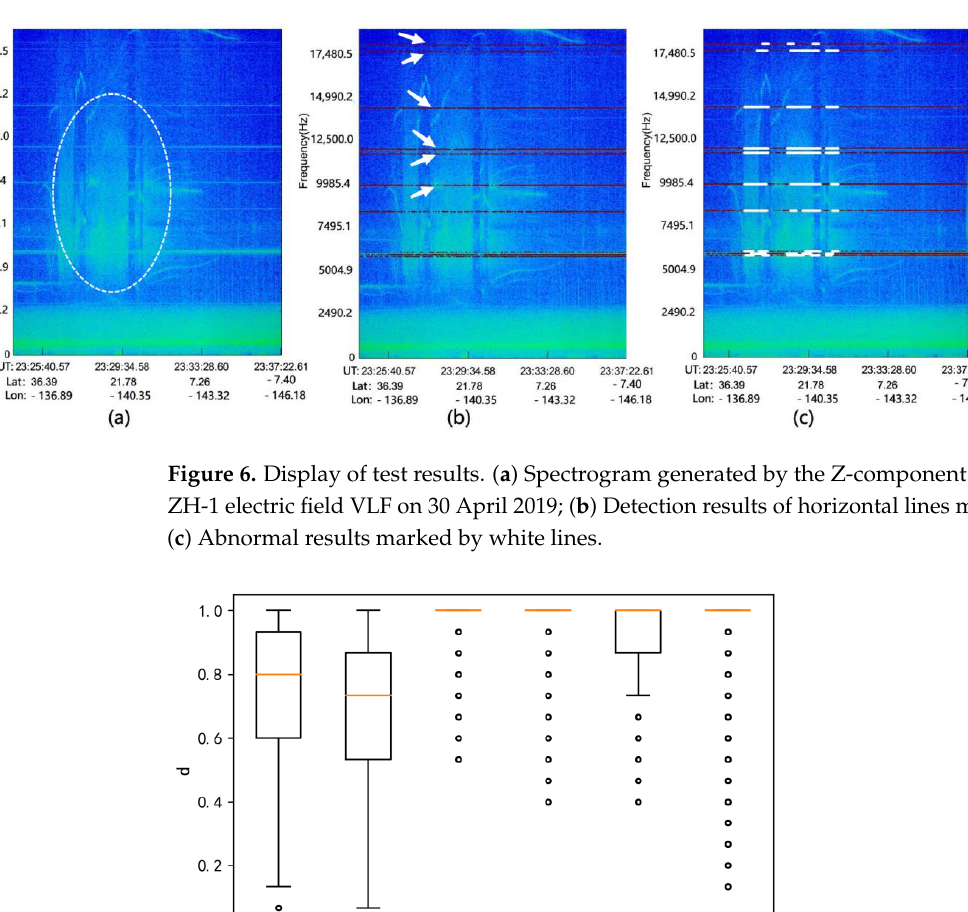
Figure 5. Histograms of the density of all windows on lines. Each subgraph represents a straight line, the title of each subgraph is the line number, and the histogram on each subgraph is the statistical distribution of the density of all the sliding Windows on a straight line. The density values range from 0 to 1, and the width of each column is 0.1. The abscissa represents the density value, and the ordinate represents the cumulative statistics that fall in a certain density range.